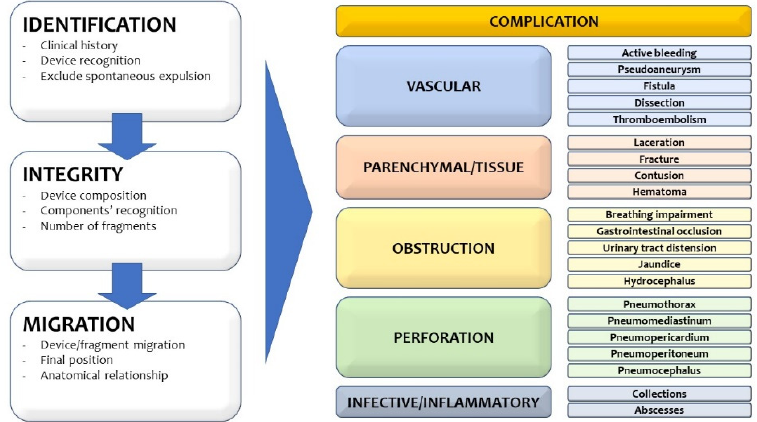
Figure 11. Systematic approach to emergencies related to medical devices.